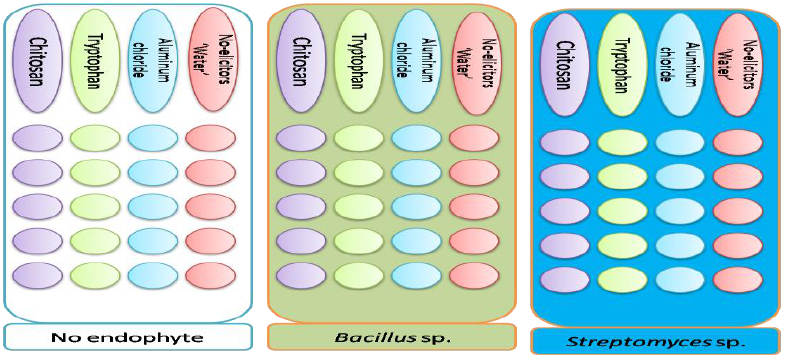
Figure 1. The experiment layout containing two factors (endophytes and abiotic elicitors).